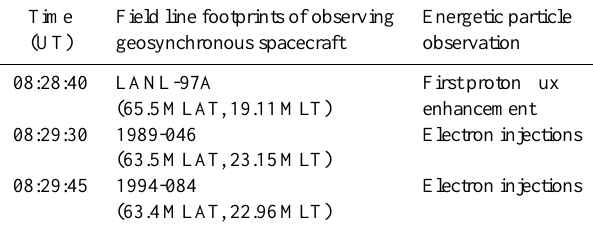
Table 3. Timings of energetic particle injection observed by geosyn- chronous satellites for the 21 December 2006 substorm event and the field line footprints of these satellites based on the T-96 model.